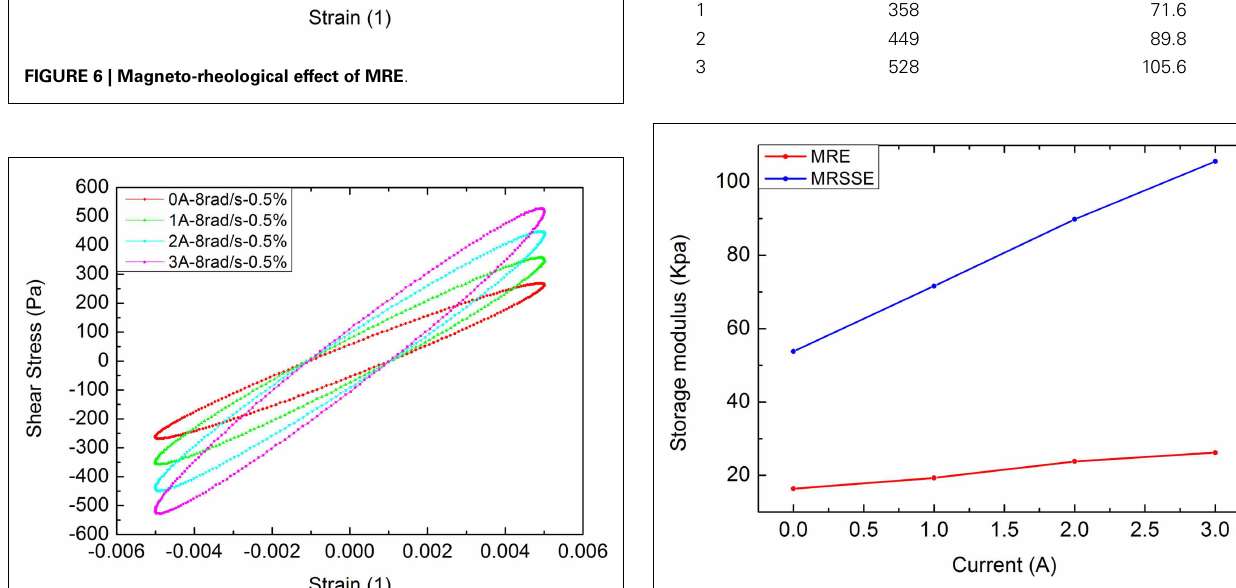
FIGURE 7 | Magneto-rheological effect of MRSSE .